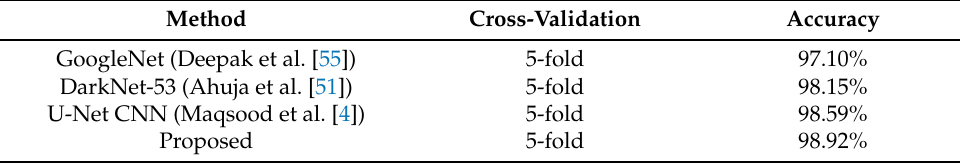
Table 9. Accuracy comparison using different cross-validation system for brain MRI dataset.